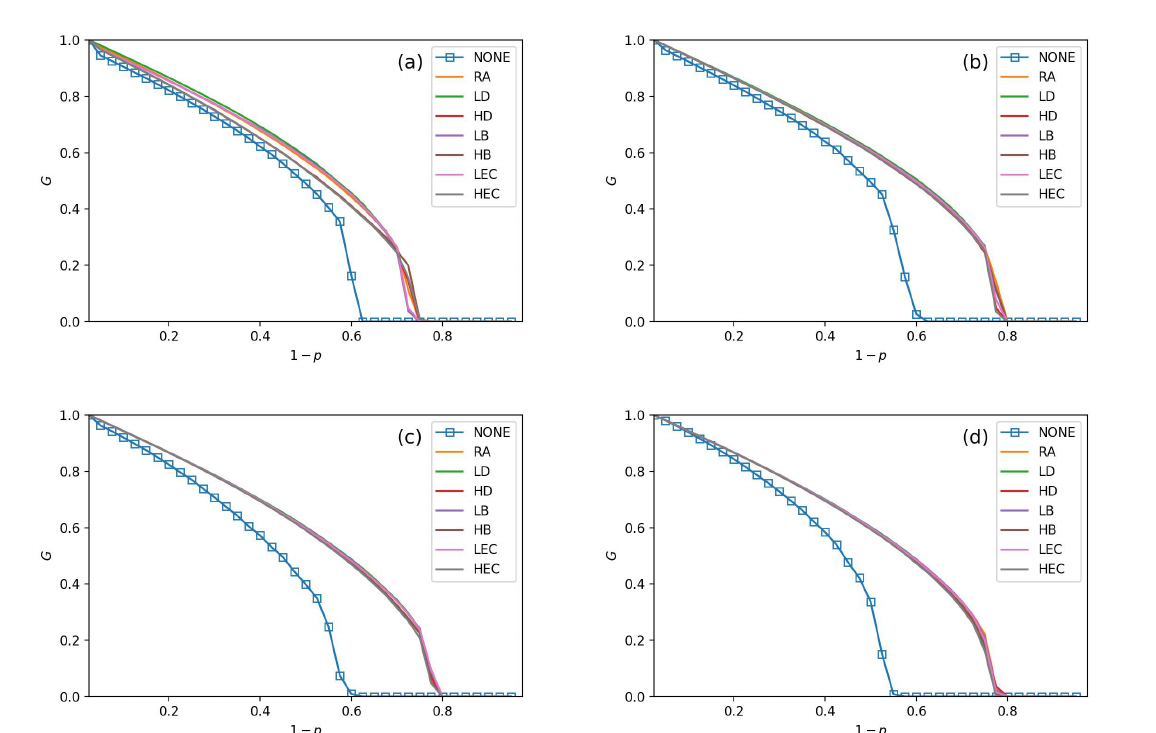
Figure 5. The fraction of function nodes when f L = 35% in ER-ER, ER-SF, SF-ER, and SF-SF system, which is shown in ( a – d ).